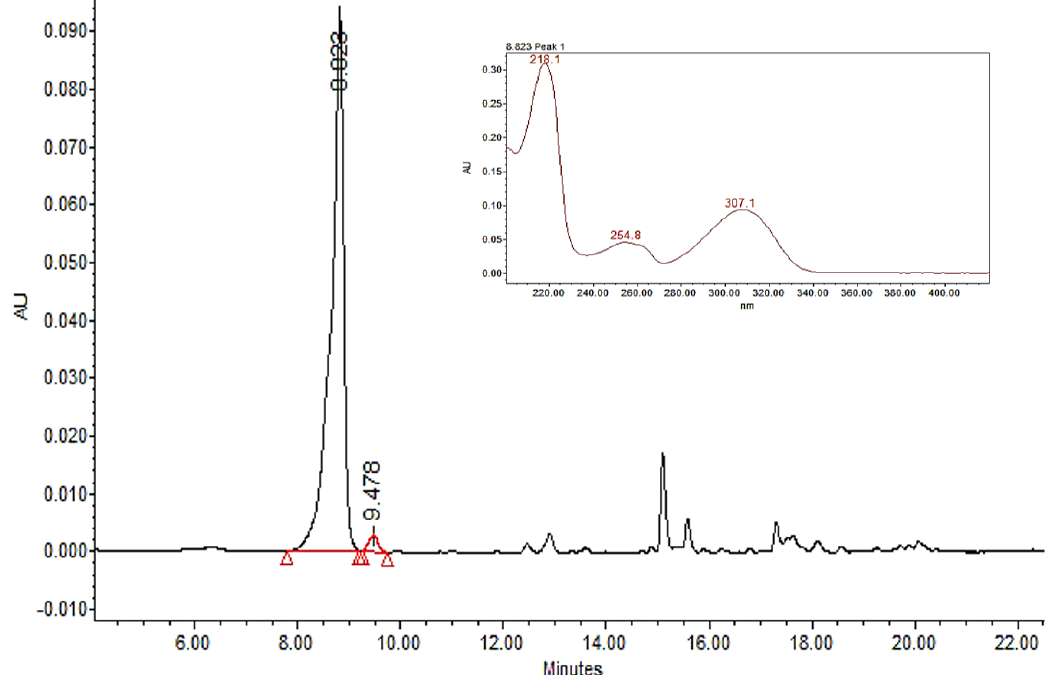
Figure 4. HPLC chromatogram of the sample elicited with 300 µM. salicylic acid.